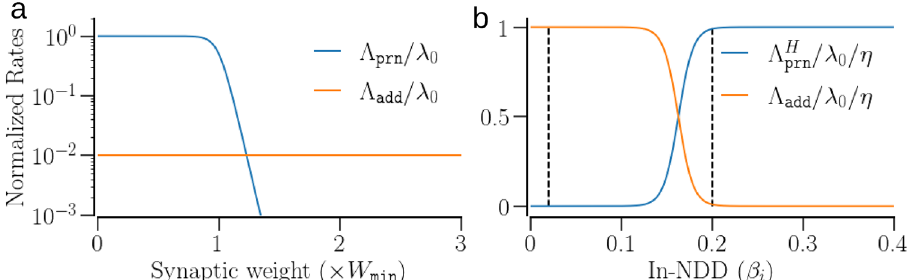
Figure 3. Structural plasticity rates as functions of the synaptic weight and the In-NDD of a neuron. ( a ) The maximum rates of pruning and addition (Eqs. 6 and 7) normalized with respect to (cid:31) 0 vs. the synaptic weight. The addition rate is shown for comparison for η = 0.01 . ( b ) The rates of homeostatic addition and pruning normalized with respect to (cid:31) 0 × η vs. the In-NDD of a neuron. The vertical lines lie at the β min = 0.02 and β max = 0.2 . The addition rate drops to ≈ 0 for β i > β max and the pruning rate increases to the maximum for β i > β min . Parameters for ( a ): β = 1 for pruning, and β = 0 for